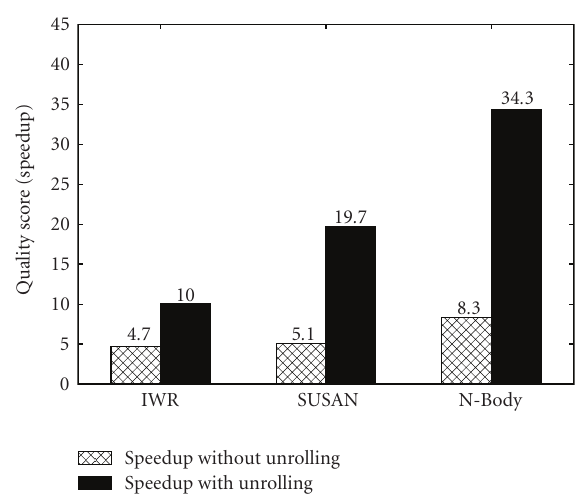
Figure 10: Quality score (speedup) comparison between unrolling and without unrolling for di ff erent applications.